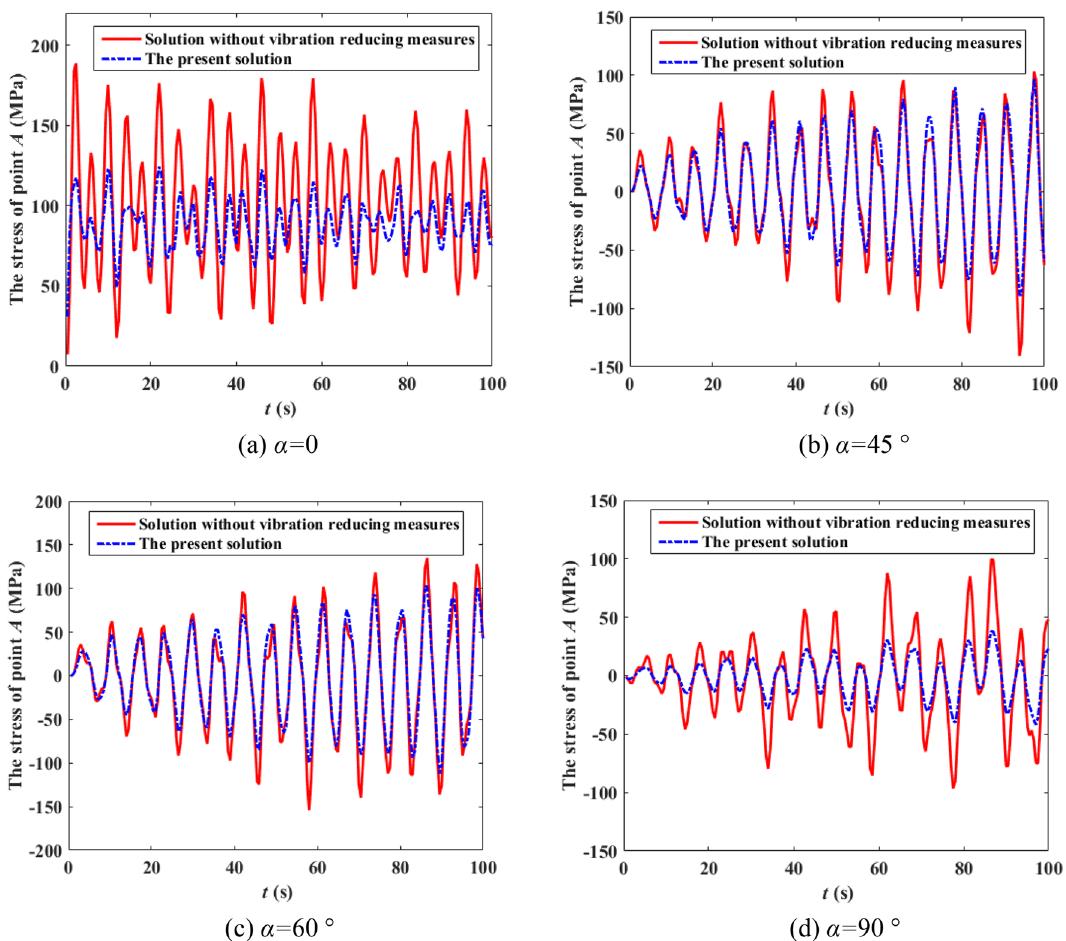
Figure 10. Stress time history curve of point A under different wind